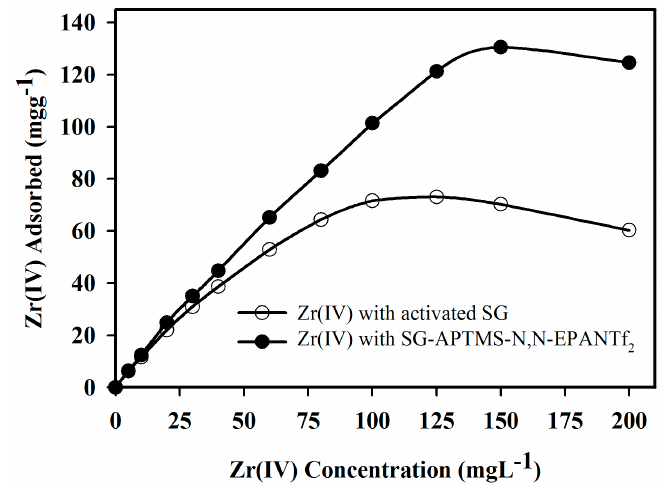
Figure 4. Adsorption profile of Zr(IV) on 20 mg activated SG and SG-APTMS-N,N-EPANTf 2 in relation to the concentration at pH 4.0 and 25 °C.